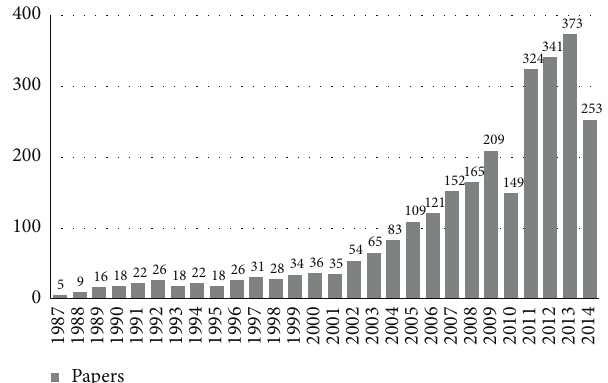
Figure 2: Number of papers dealing with stem cells in dentistry published during the last 27